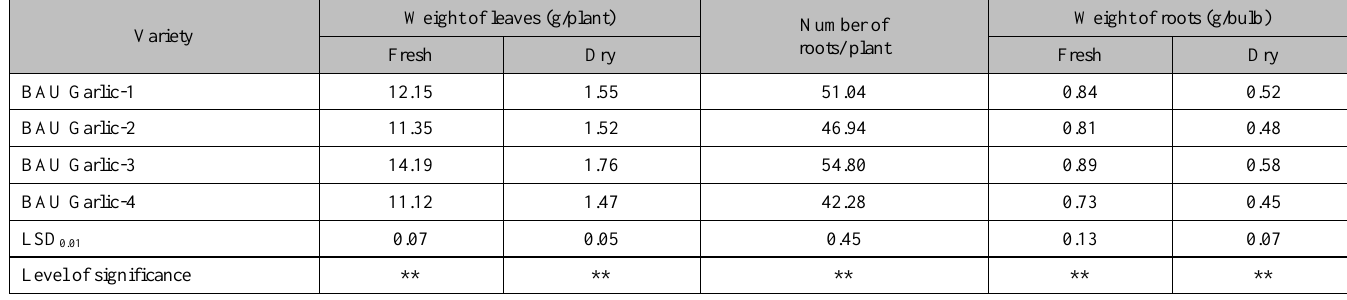
Table 4. Main effects of different variety on fresh weight, dry weight of leaves, number of roots, fresh weight and dry weight of roots. Variety